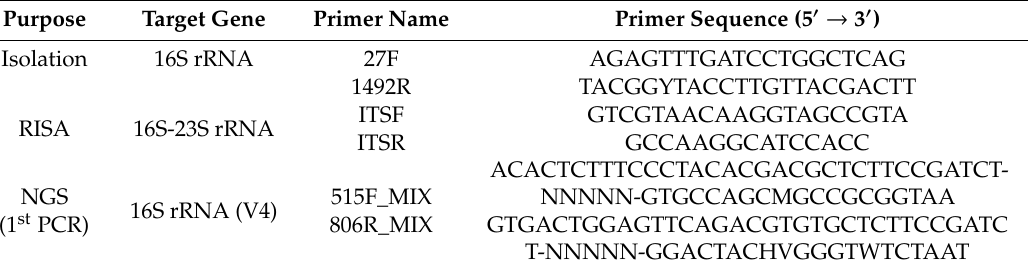
Table 1. Sequences of primers used for PCR in this